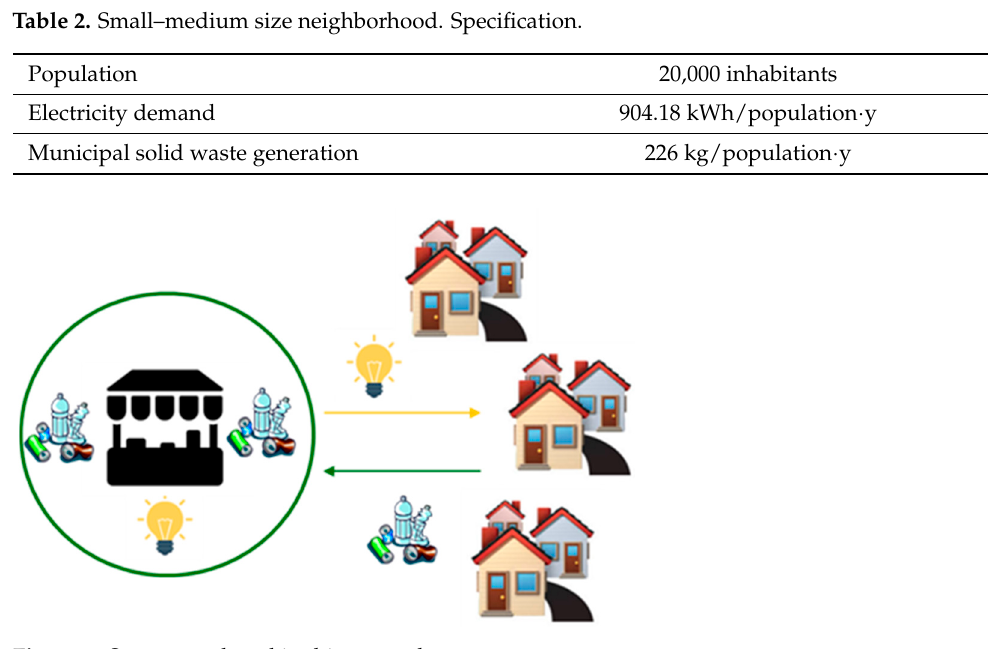
Figure 2. System analyzed in this